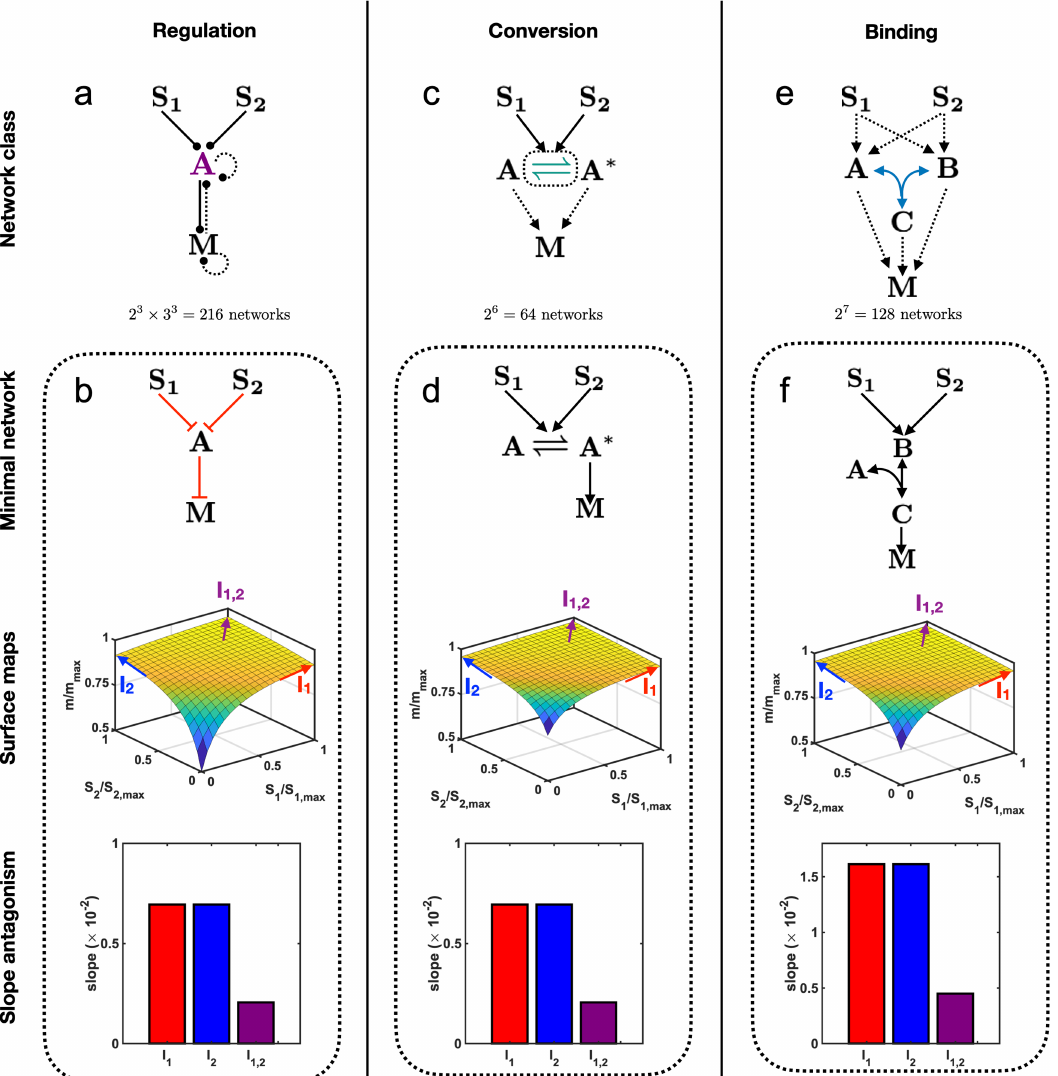
Fig. 4 Slope antagonism. Slope antagonism occurs if the derivative of the output with respect to each input, in the absence of the other input, is larger than the derivative when both inputs are present. The minimal a regulation network class contains b a minimal network that achieves slope antagonism by the repression of a repressor. The minimal c conversion network class contains d a minimal network that achieves slope antagonism by pathway saturation. The minimal e binding network class contains f a minimal network that achieves slope antagonism by complex formation. In all cases, the output saturates as a function of the inputs (surface maps) and thereby shows slope antagonism (bar graphs). The slopes at I 1 , I 2 , and I 1,2 are calculated at S i ¼ S i ; max (see “ Code availability ” ). We see in Fig. 4d (top) that both inputs catalyze the conversion of A to A *, and A * activates the output. Due to conservation of the intermediate species, the presence of both inputs can bring the conversion reaction closer to its saturation point (with all molecules in the A * state) than either input alone. Thus, the output saturates as a function of the inputs, and the slope is lowest when both inputs are present (Fig. 4d, middle), i.e., the network exhibits slope antagonism (Fig. 4d, bottom). Although the network and mechanism are different, the